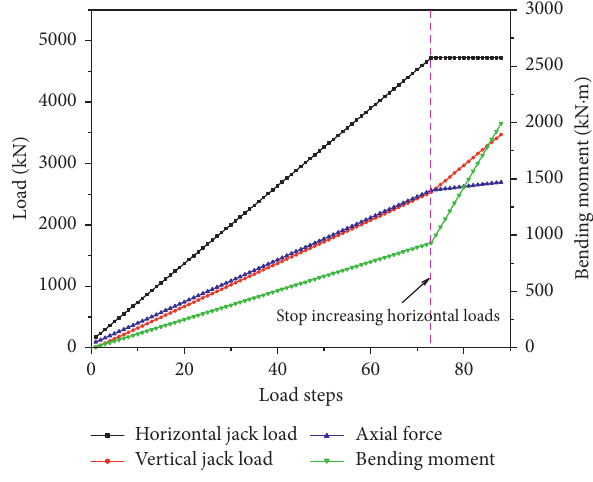
Figure 6: Test loading process.